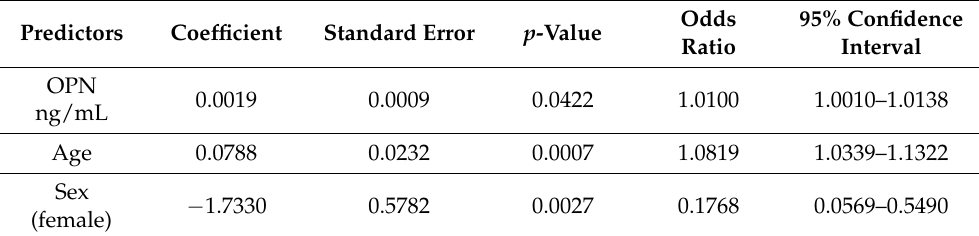
Table 4. Logistic regression multivariate. We performed a logistic regression multivariate stepwise to examine the correlation between OPN levels at baseline (t0) and negative disease evolution measured as in-hospital death or ICU admission after demographic and clinical severity variables correction. NEWS2 score and PiO2/FiO2 did not enter in the model.